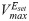
IRT1 overexpression leads to an increased iron set-point, iron overload and to saturation in the iron-dependent degradation of IRT1.(a) Increase of IRT1 synthesis rate k3 at different external iron levels. At times t = 50 and t = 100 (indicated by arrows) the values of Feext and k3 are changed as indicated in the figure. As long as the IRT1 syntesis rate jIRT1-synth is lower than its degradation rate (t = 0 to t = 100), the cytosolic iron concentration is under homeostatic control at its new set-point Eq (12). When jIRT1-synth becomes larger than jIRT1-degr iron levels rise and the IRT1 degradation rate jIRT1-degr goes into saturation (t = 100 to t = 150). The negative feedback loop is broken and iron homeostasis lost. (b) Demonstration of iron-independent degradation of IRT1 when jIRT1-synth > jIRT1-degr. The overexpression rate (k3) is kept constant at 1 × 103 while external iron concentrations Feext are changing. For each Feext value (5.0, 0.5, and 0.01) the IRT1 degradation rate is at its maximum value VmaxEset and independent of the cytosolic iron concentration. Rate constants, except k3, are as in Fig 3c. (c) Calculated IRT1 expression levels shown as “dot-blots”. (d) Corresponding experimental results by Barberon et al. (Fig 1D in [23]).